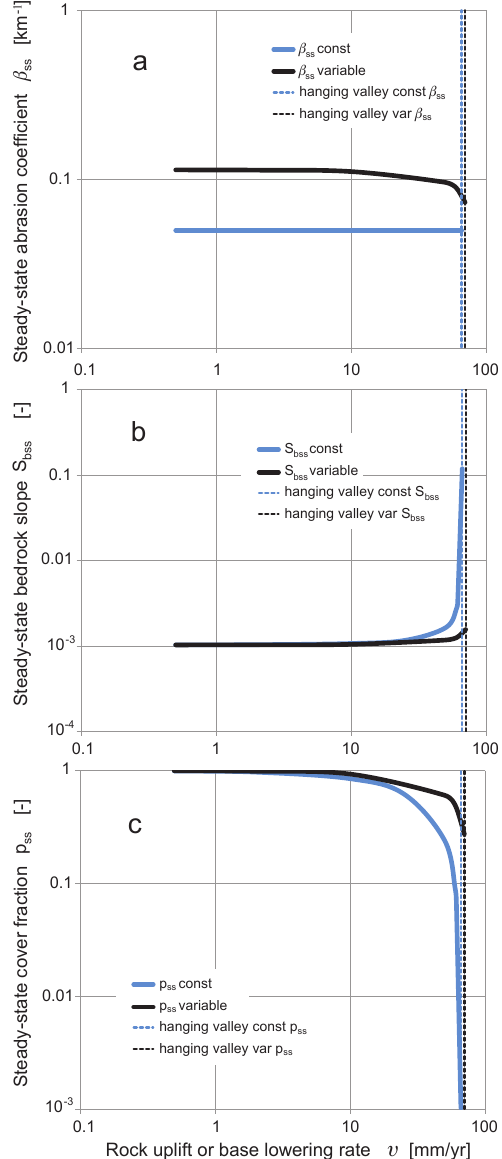
Figure 10. Variation at steady state (black curves) of (a) abrasion coefficient β ss , (b) bedrock slope S bss and (c) cover fraction p ss and parameter ϕ with rock uplift or base lowering rate υ , for a low bedload feed rate of 3.5 × 10 4 tyr − 1 . The cases of constant, spec- ified β ss and S bss varying according to Eq. (34) are shown as blue curves. The vertical dashed lines denote the incipient conditions for the formation of a hanging valley. The predictions are the same for the CSA and MRSAA